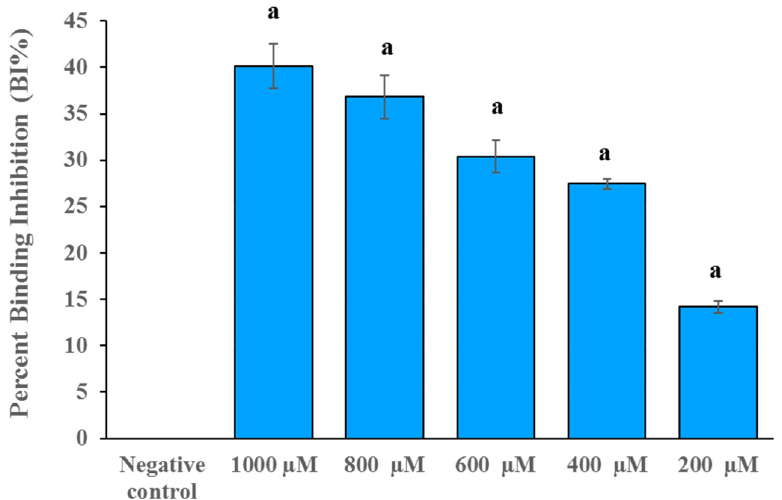
Figure 6. The spike RBD and ACE2 binding inhibition of DB36 in a dose-dependent manner. Data are expressed as the relative mean value with an error bar (SEM) from three independent experiments (each performed in duplicate). BS-R2B2 (MonoRab SARS-CoV-2 neutralizing antibody) at 1 µg/mL was used as a positive control. The letter ‘a’ denotes a significant difference compared with the negative control ( p < 0.05) based on one-way ANOVA using GraphPad Prism 5.02.